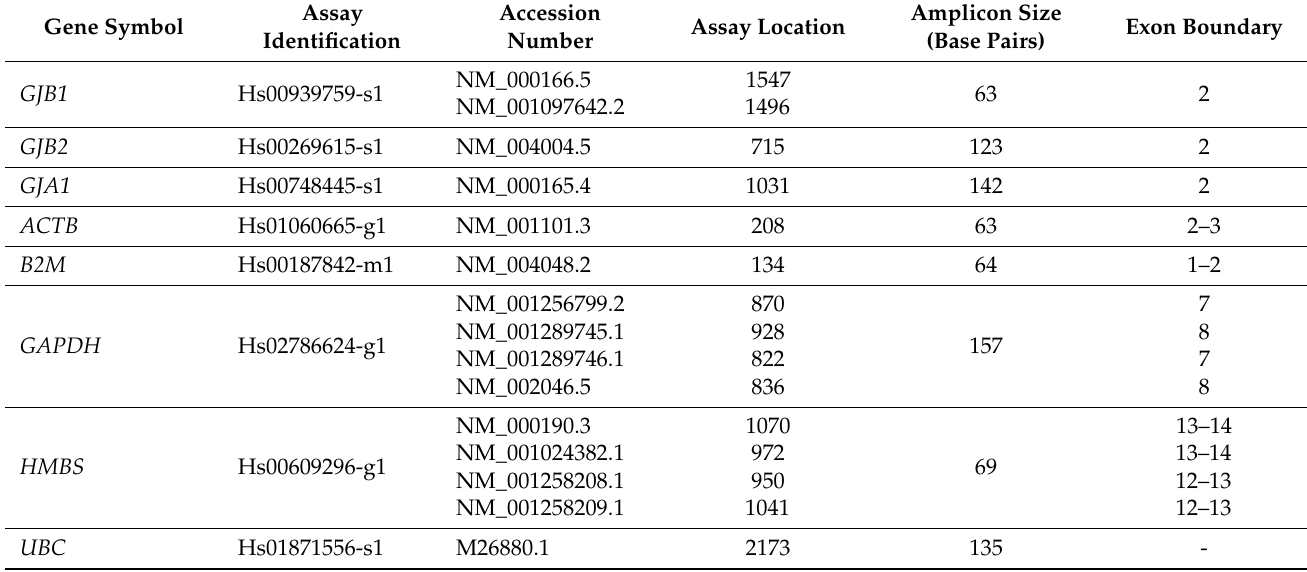
Table 3. Primers and probes for RT-qPCR analysis of connexin and housekeeping genes. Assay identification, accession number, assay location, amplicon size, and exon boundaries are listed (GJB1, Cx32; GJB2, Cx26; GJA1, Cx43; ACTB, actin beta; B2M, beta-2-microglobulin; GAPDH, glyceraldehyde-3-phosphate dehydrogenase; HMBS, hydroxymethylbilane synthase; UBC, ubiquitin